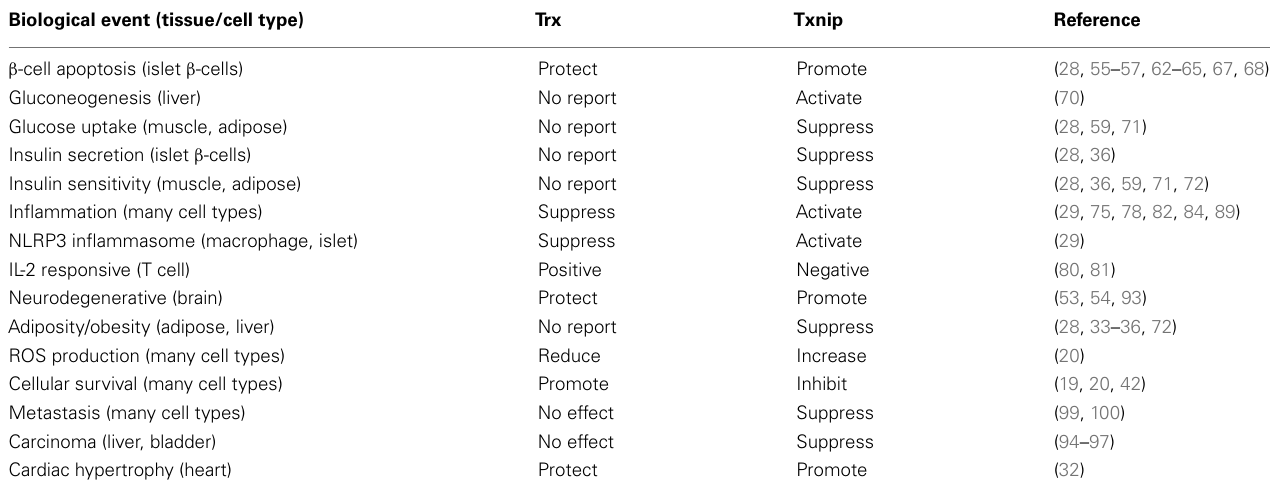
Table 1 | Reciprocal function betweenTrx1 andTxnip